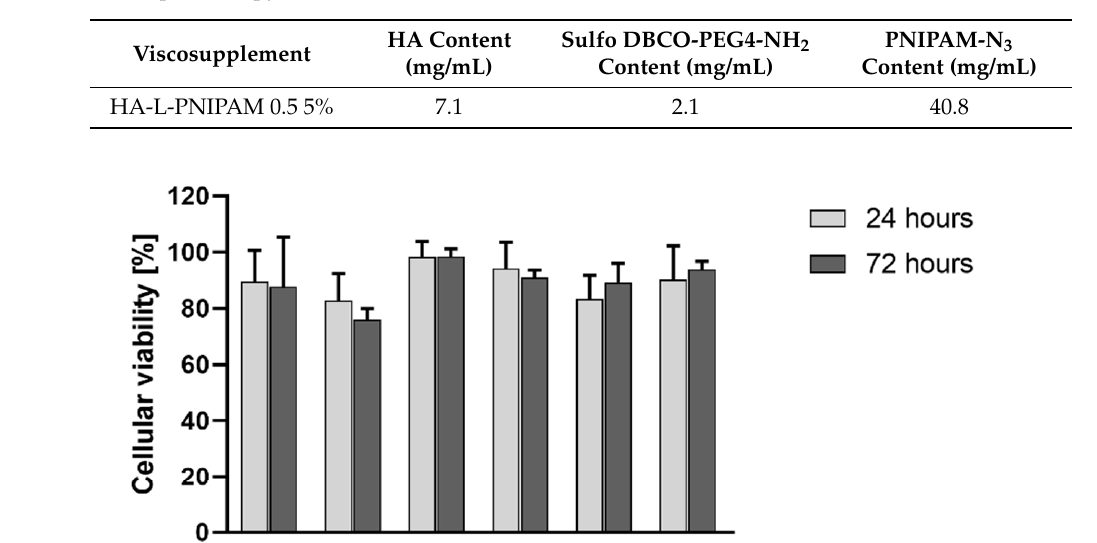
Table 2. Summary of HA-L-PNIPAM 0.5 5% contents calculated according to values obtained in 1 H NMR spectroscopy.